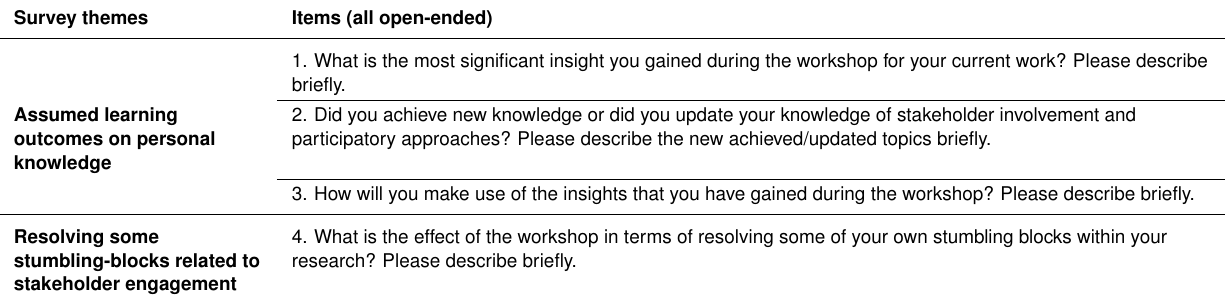
Table 2. Survey themes and items of the online ex-post